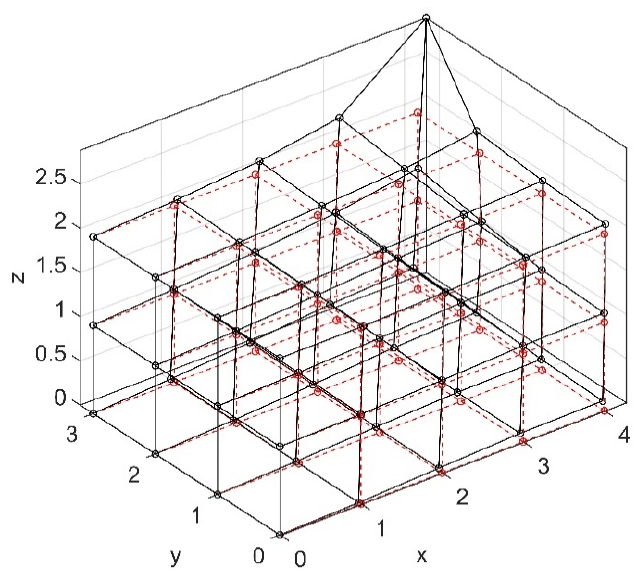
Figure 2. The model and its deformation diagram.